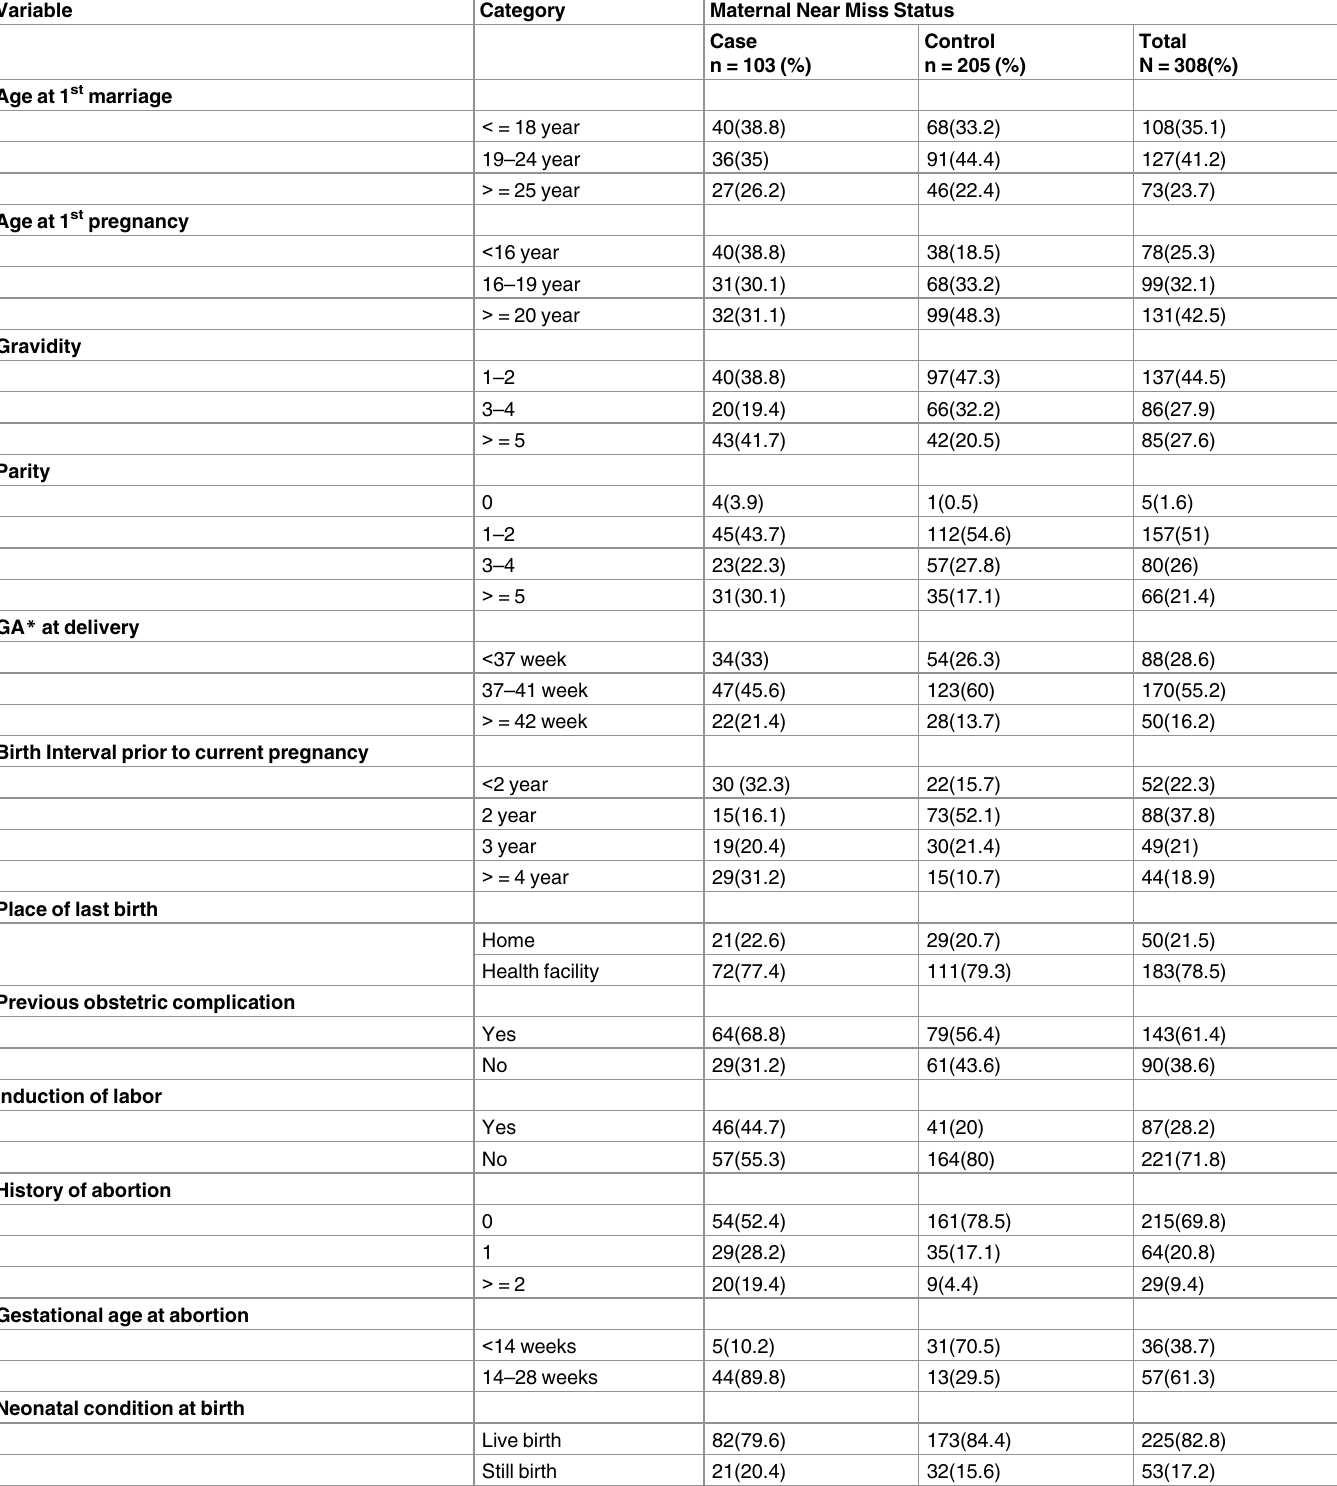
Table 2. Obstetric characteristics of mothers admitted in public hospitals, Tigray, Northern Ethiopia, 2016. (N =